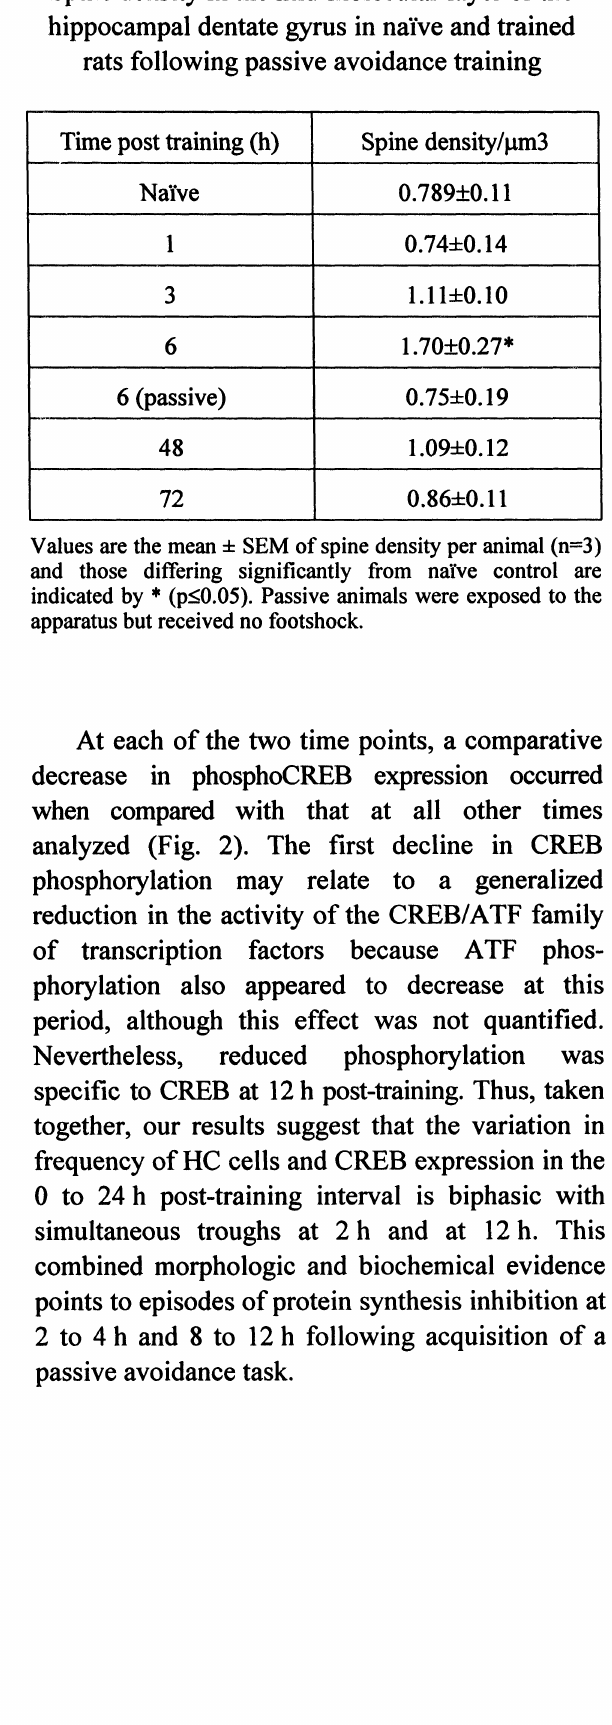
Spine density in the mid-molecular layer of the hippocampal dentate gyrus in naive and